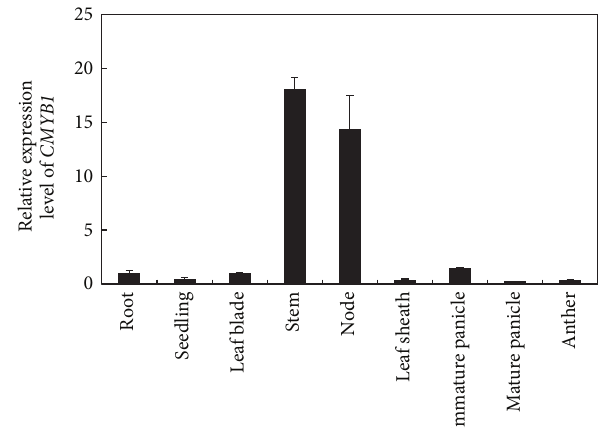
Figure 2: The qRT-PCR analysis of expression of CMYB1 in various rice